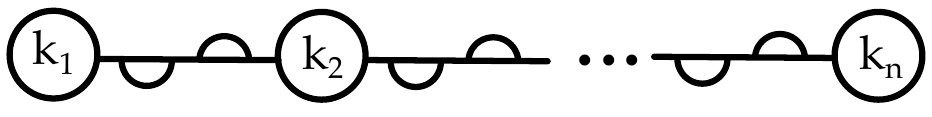
Figure 11 . Quiver corresponding to the N = 2 enhancement point of b T N =1 [(cid:10)